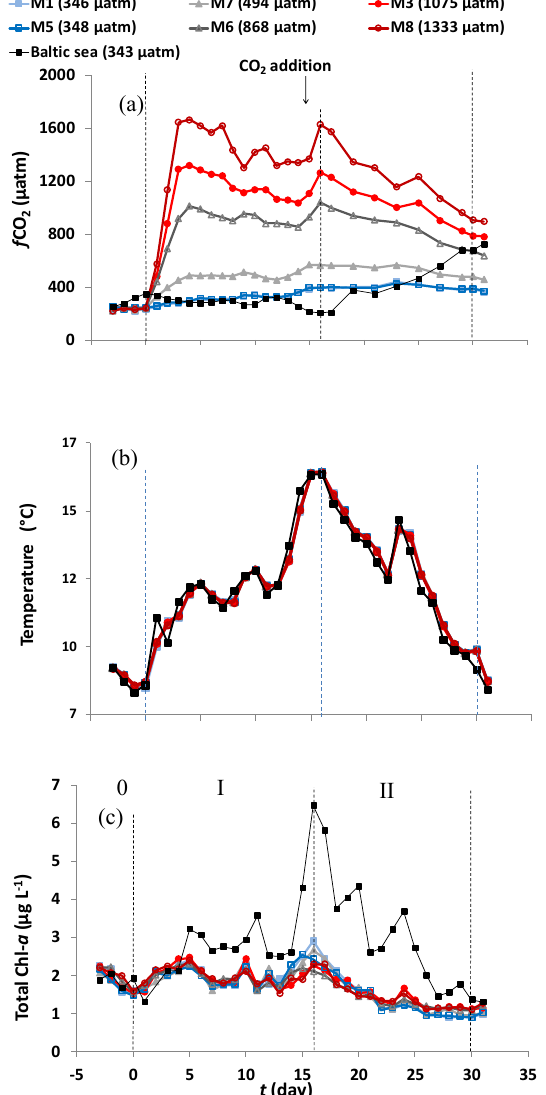
Figure 1. Daily measurements of (a) f CO 2 , (b) mean temperature, and (c) total chlorophyll a in the mesocosms and surrounding Baltic Sea waters. Dashed lines represent the three phases of the experi- ment, based on the Chl a